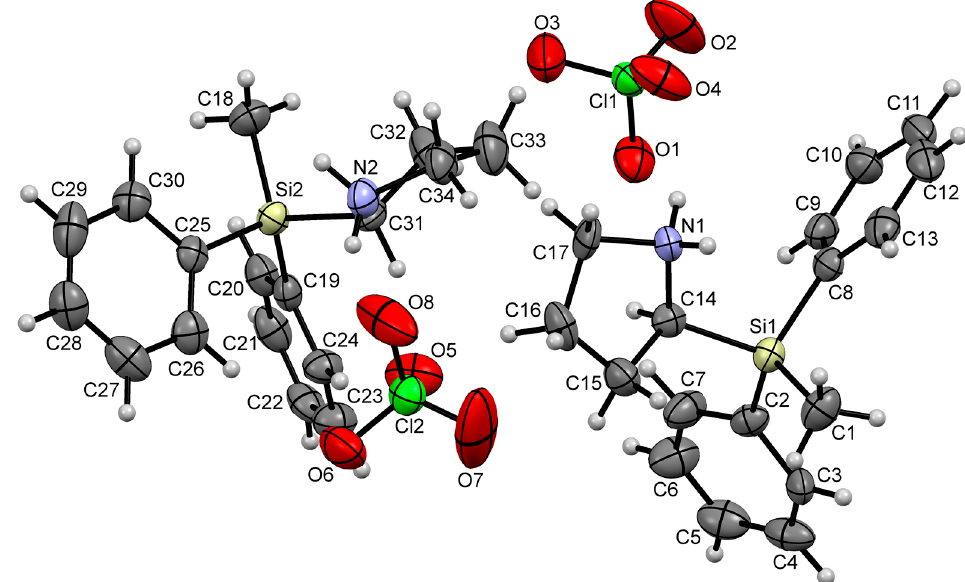
Figure 4. Molecular structure (ORTEP plot) of compound ( S )- 2 ·HClO 4 in the crystal, with the displacement ellipsoids set at the 50% probability level. Selected bond lengths (Å) and angles (°): Molecule ( S )- 2 ·HClO 4 - A : C(1)–Si(1) 1.852(6), C(2)–Si(1) 1.855(6), C(8)–Si(1) 1.871(5), C(14)–Si(1)